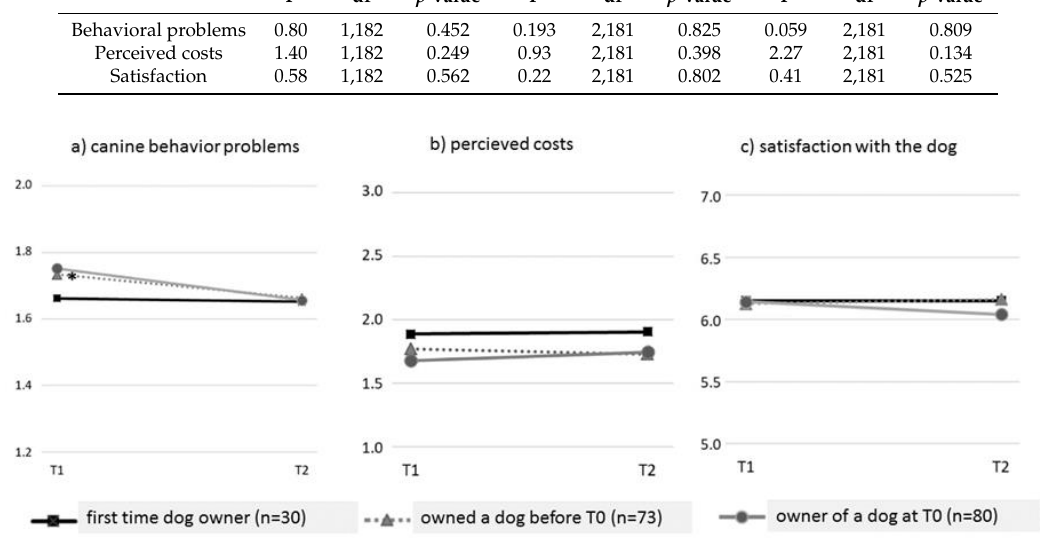
Figure 3. Changes over time for ( a ) canine behavioral problems, ( b ) perceived costs, ( c ) and satisfaction with the dog. An asterix (* placed below the line) indicates a significant increase or decline between two time points.